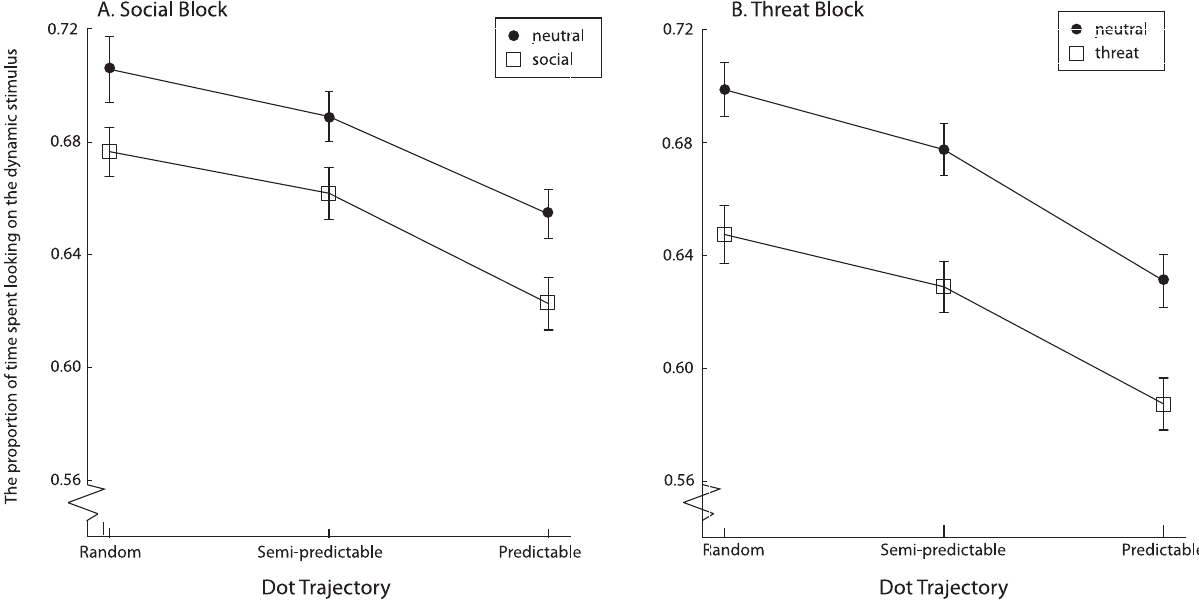
Fig 4. The proportion of time spent looking on the dynamic stimulus, separately for the neutral and non-neutral (social or threat, depending on the task) stimuli. Error bars denote within-subjects 95% confidenceintervals.